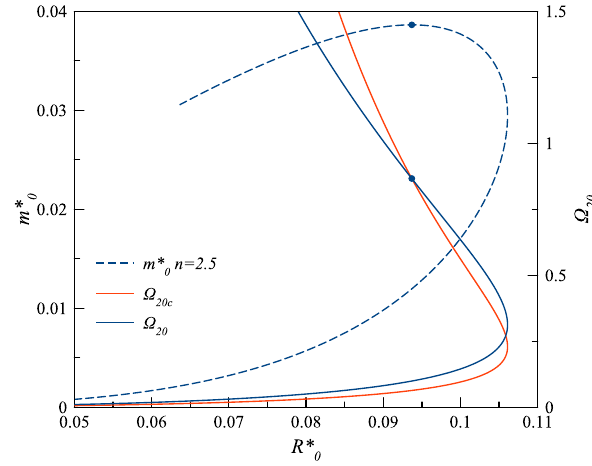
= m ∗ ( R ∗ ) diagram for the relativistic 0 0 0